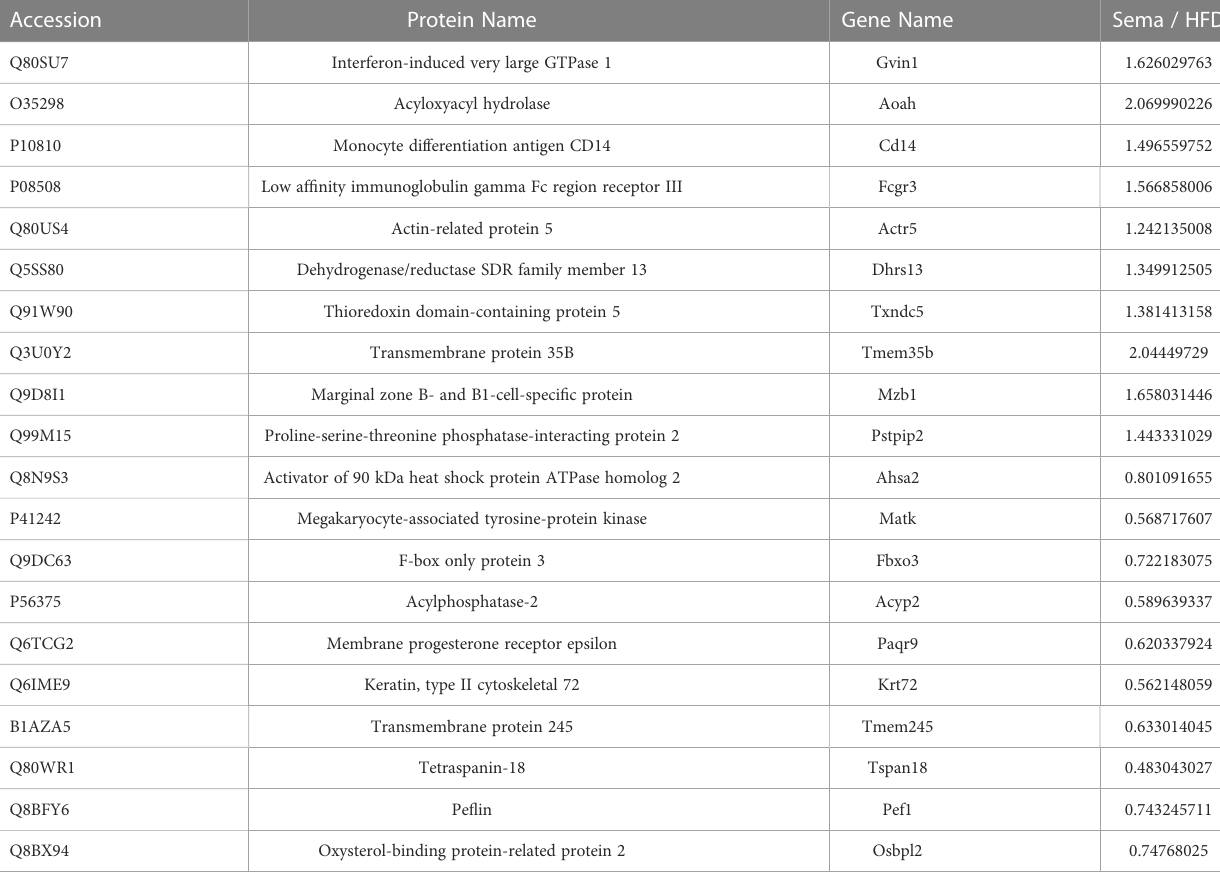
TABLE 1 List of the top 10 DEPs signi fi cantly up/down-regulated between the Sema and HFD